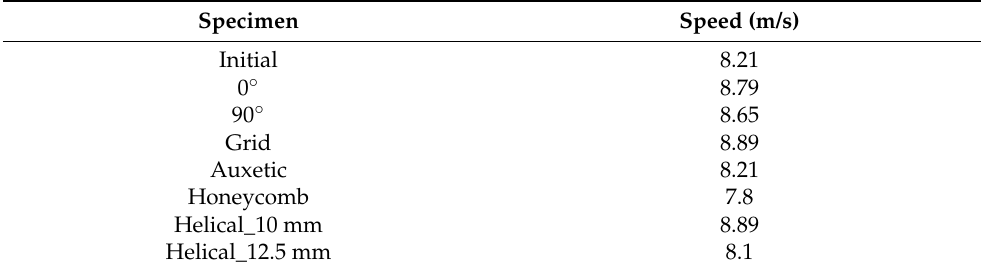
Figure 13. Helical specimen modelling technique in ABAQUS: ( a ) initial 22 MnB5 steel tube; ( b ) Martensite helical pattern; ( c ) Tube with Helical pattern. Table 2. Speed of Hydraulic punch in each test